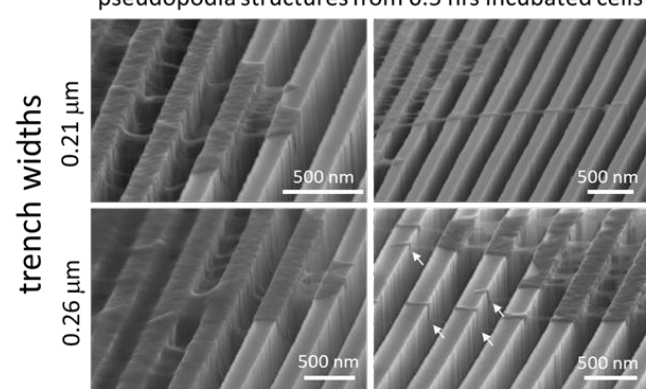
Figure 9. ( a ) Representative 70°-tilted high-magnification SEM micrographs of adherent cells on comb structures with various trench widths. White arrows indicate examples of pseudopodia that bridged across the trenches; ( b ) schematic illustrations of two spreading behaviors of pseudopodia across trenches—trench bridging and conformal trench coverage; ( c ) typical 70°-tilted SEM micrographs of cells incubated on parallel trench structures with trench widths of 0.21 and 0.26 μm for 0.5 h. White arrows indicate examples of pseudopodia that bridged across the trenches. In region (ii), where the trench widths are between 1 and 10 μm, conformal surface coverage was the dominant pseudopodia-spreading characteristic (see Figure 9a). This morphology was also